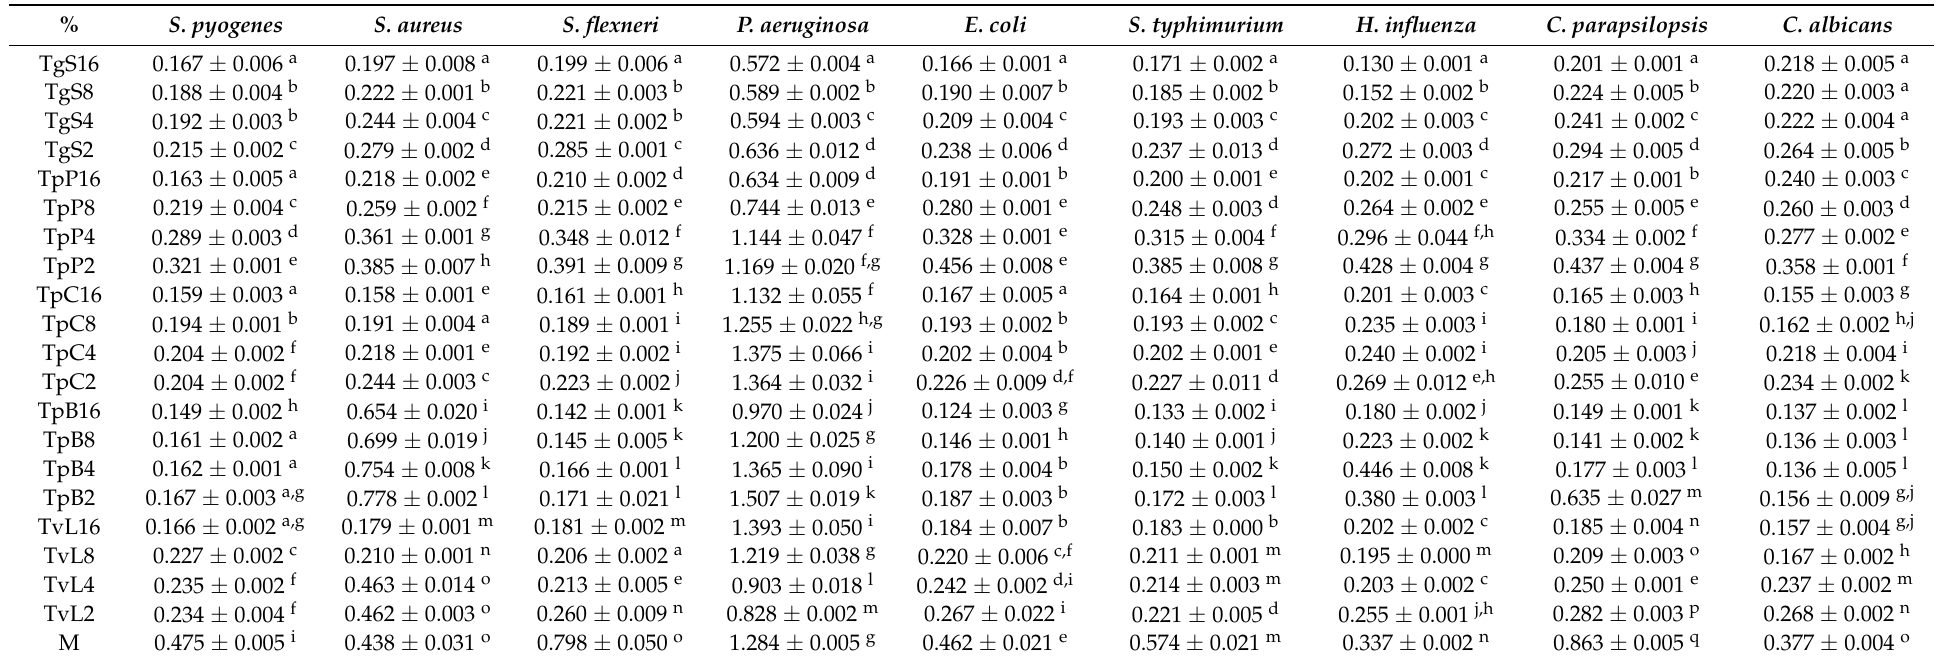
Table 3. The optical density (OD) mean values of EOs at 540